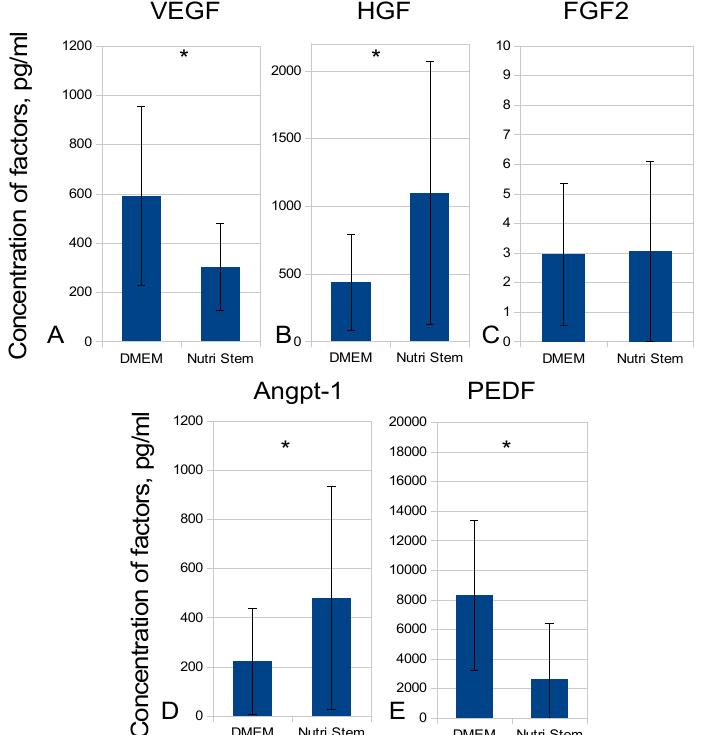
Figure 2. Comparison of growth factor concentrations in MSC-CM based on different MSC culture media at day 7. The data are presented as mean concentrations in pg/mL ± SD. * p < 0.05 after Student’s t -test analysis. All manufactured 36 MSC-CM samples were analyzed.